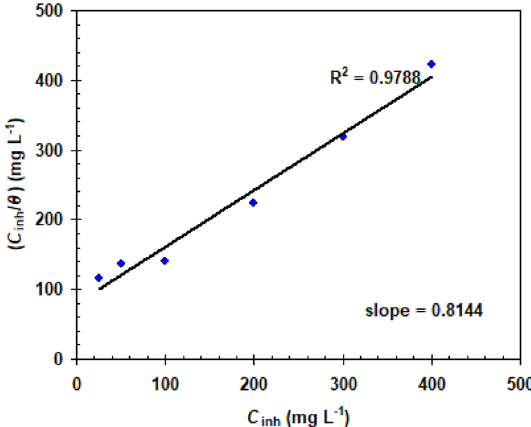
Figure 8. Langmuir isotherm for the studied BLE extract at 298 K.